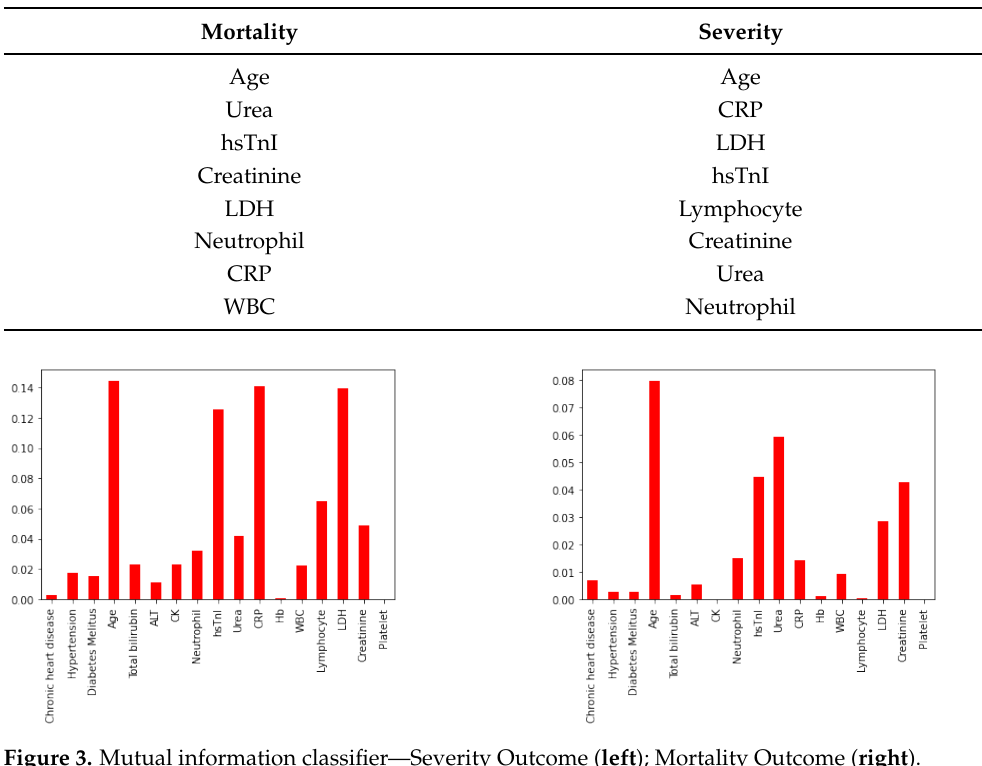
Figure 3. Mutual information classifier—Severity Outcome ( left ); Mortality Outcome ( right